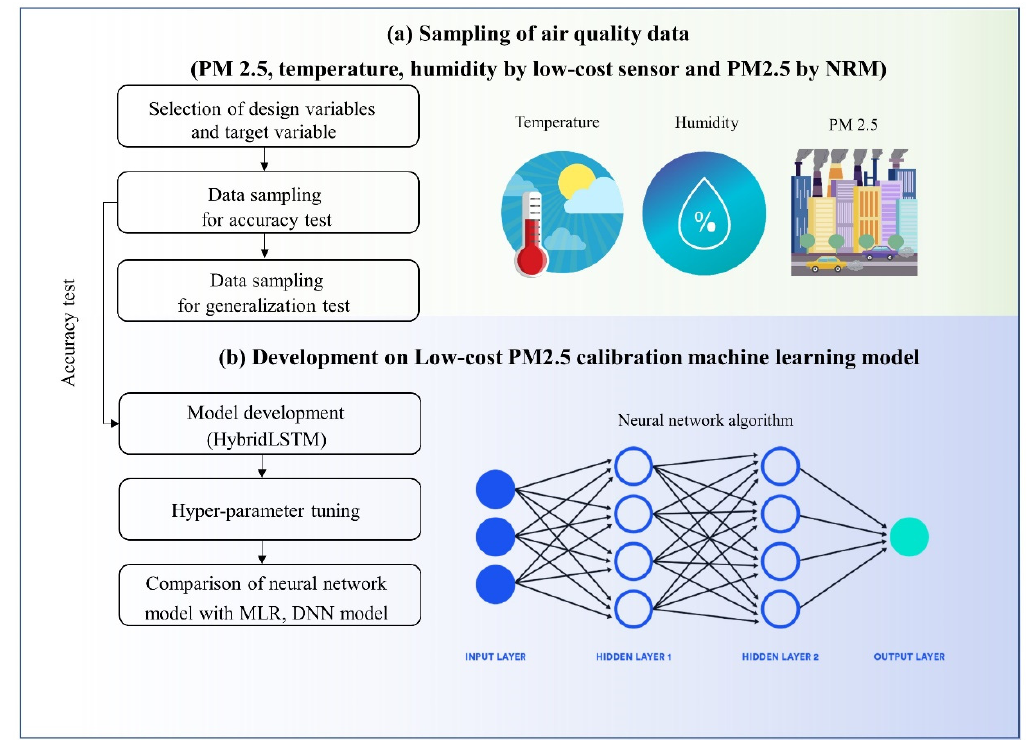
Figure 1. Research flow chart. This work is performed in two steps: ( a ) data collection for PM 2.5 , temperature and humidity by low-cost sensor and PM 2.5 by gravimetric instrument with high accuracy. ( b ) Machine learning model development based on the collected dataset. Calibration performance from the developed model is compared with raw data by low-cost sensor and calibration results by benchmark method (multi-linear regression method, DNN).